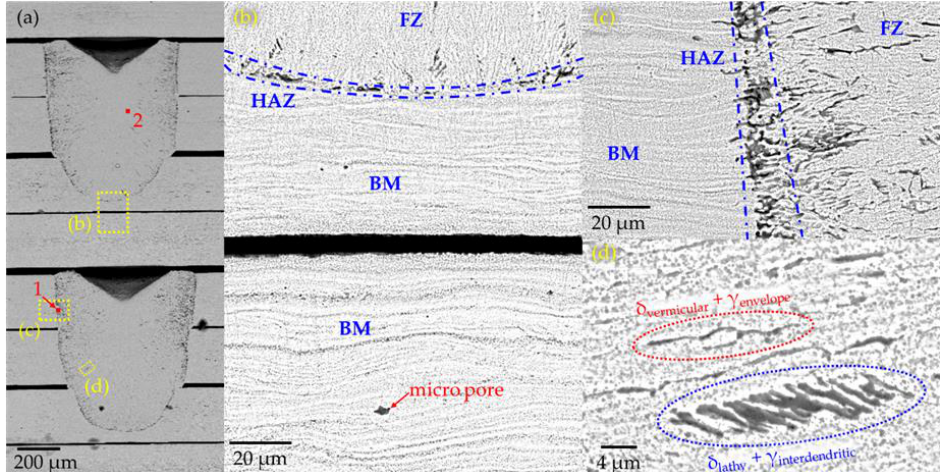
Figure 10. ( a ) Metallography of two micro spot welding ( b ) Lowest point of spot welding, ( c ) Lateral interface between spot welding and raw material ( d ) microstructure in the fusion zone.